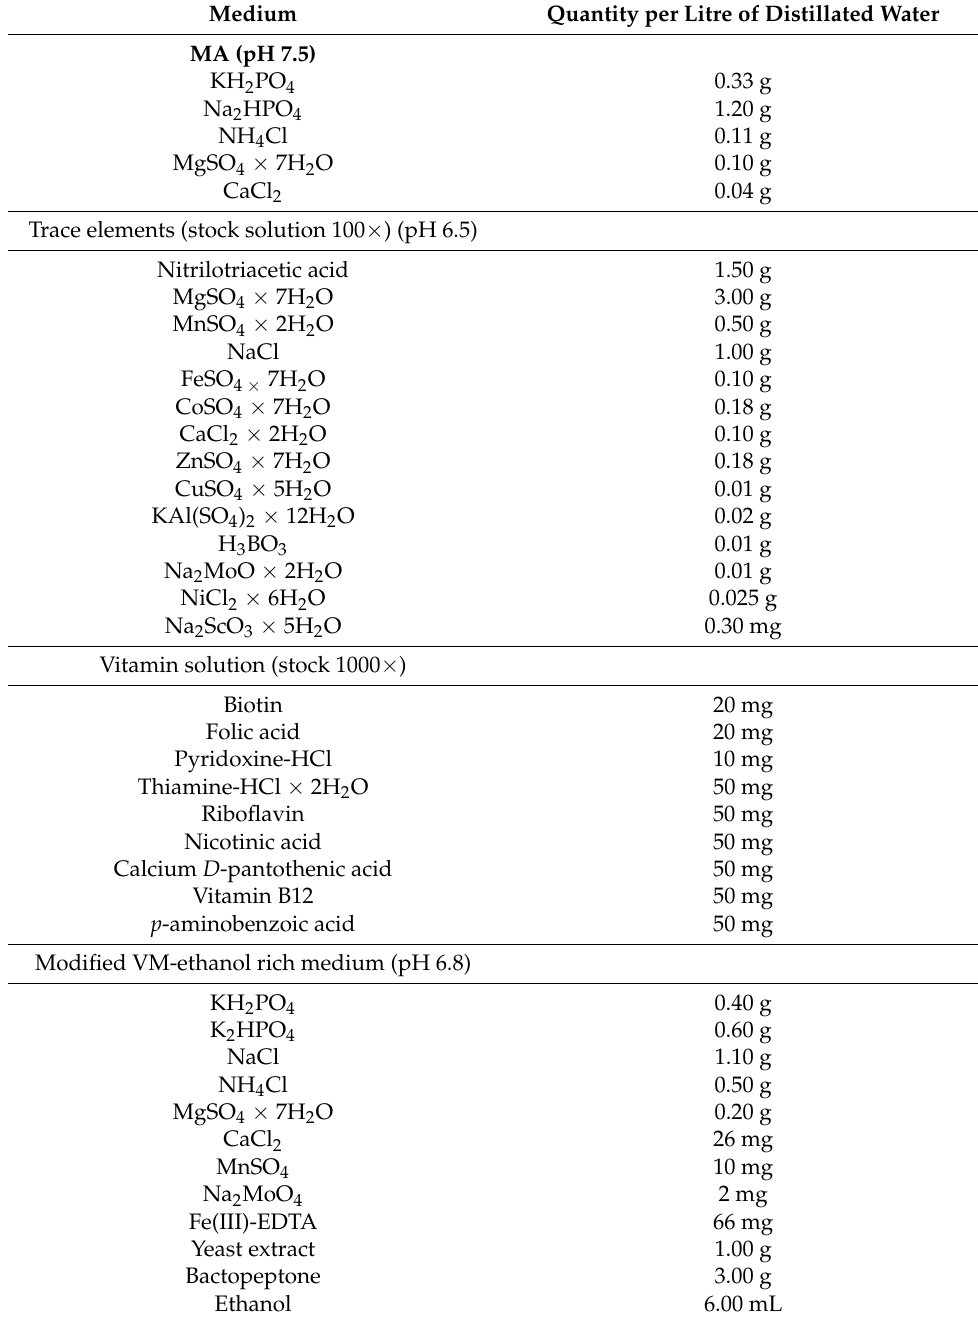
Table 2. Composition of growth media used in this